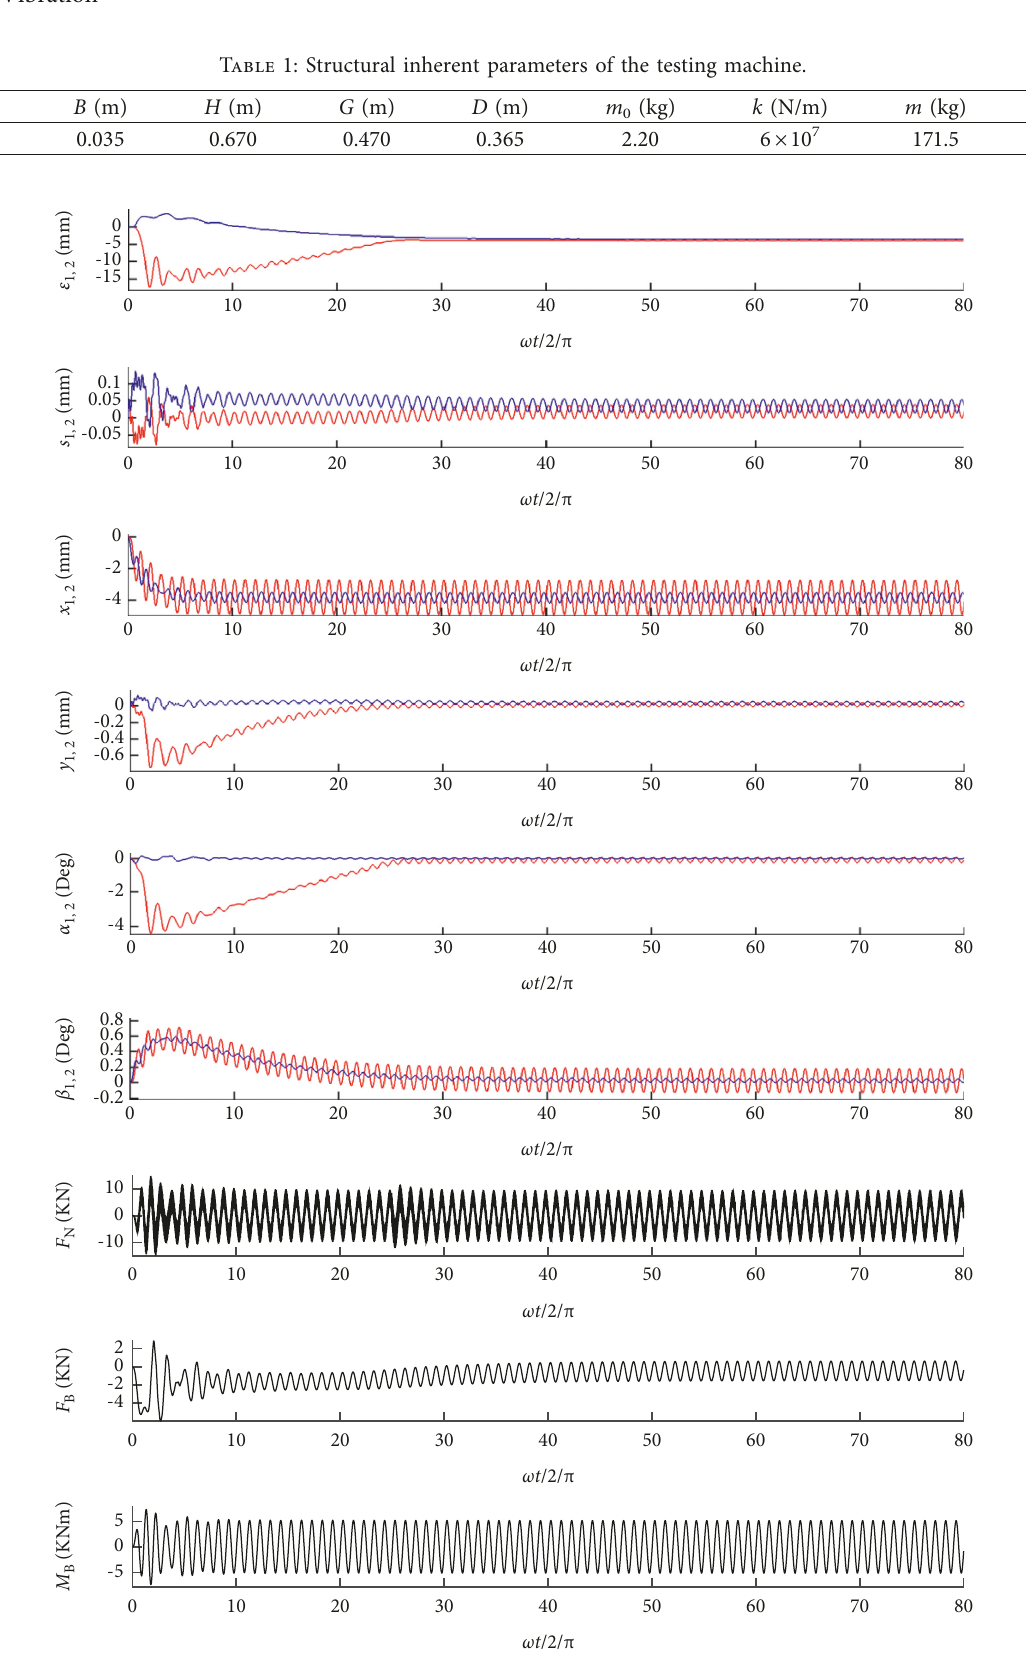
Figure 3: Instantaneous response history of the translational and angular displacements and the tested shaft loads. Numerical solution at ω � 30Hz and A F � 5kN. Red line: ( X 1 , s 1 , x 1 , y 1 , α 1 , β 1 ), blue line: ( X 2 , s 2 , x 2 , y 2 , α 2 , β 2